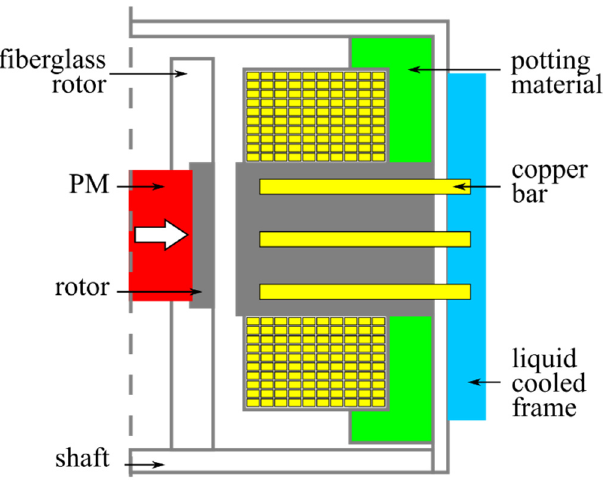
Figure 22. Hybrid cooling method for axial PM machine (passive + jacket) [96].